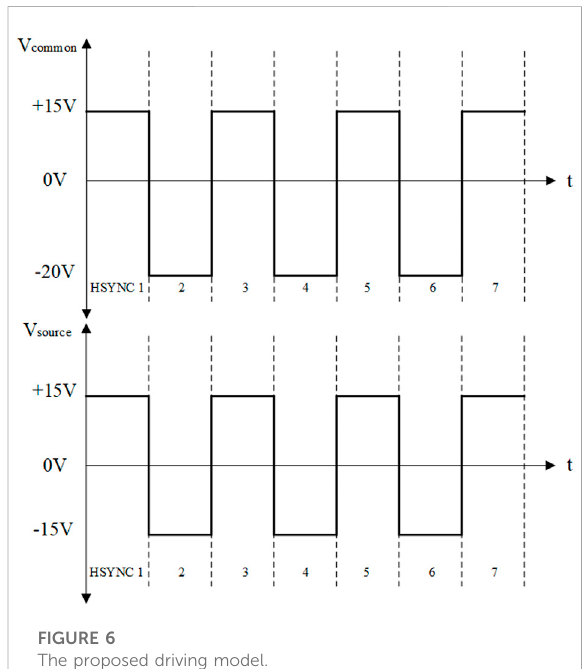
FIGURE 6 The proposed driving